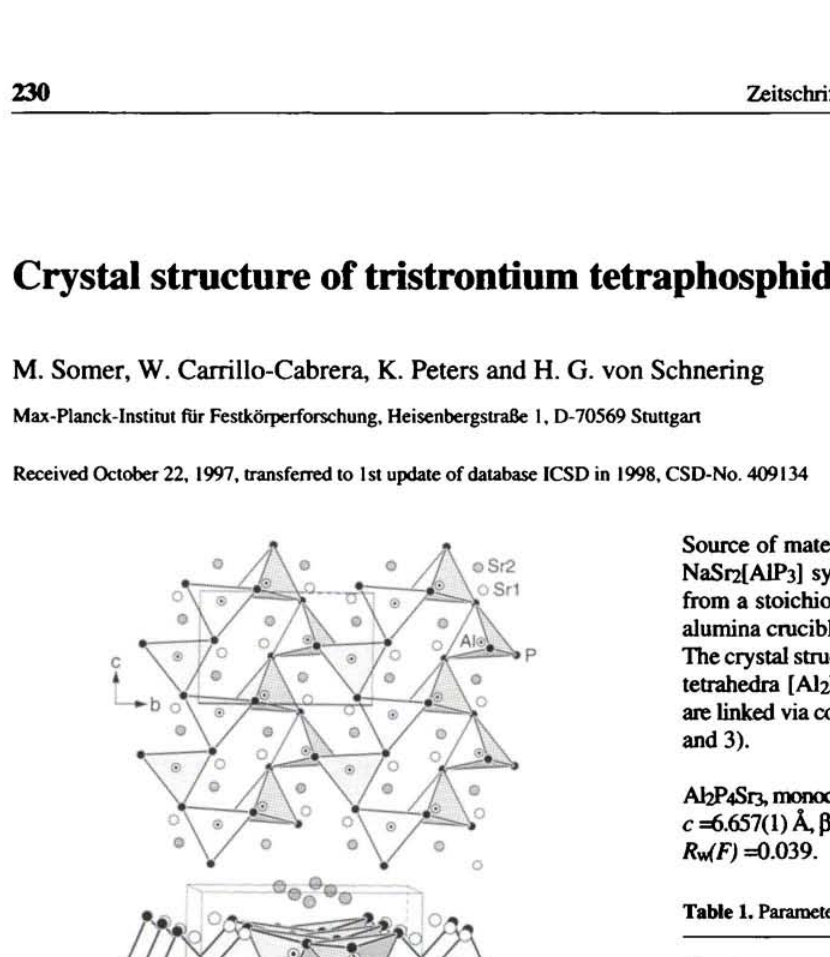
Table 1. Parameters used for the X-ray data collection Crystal: